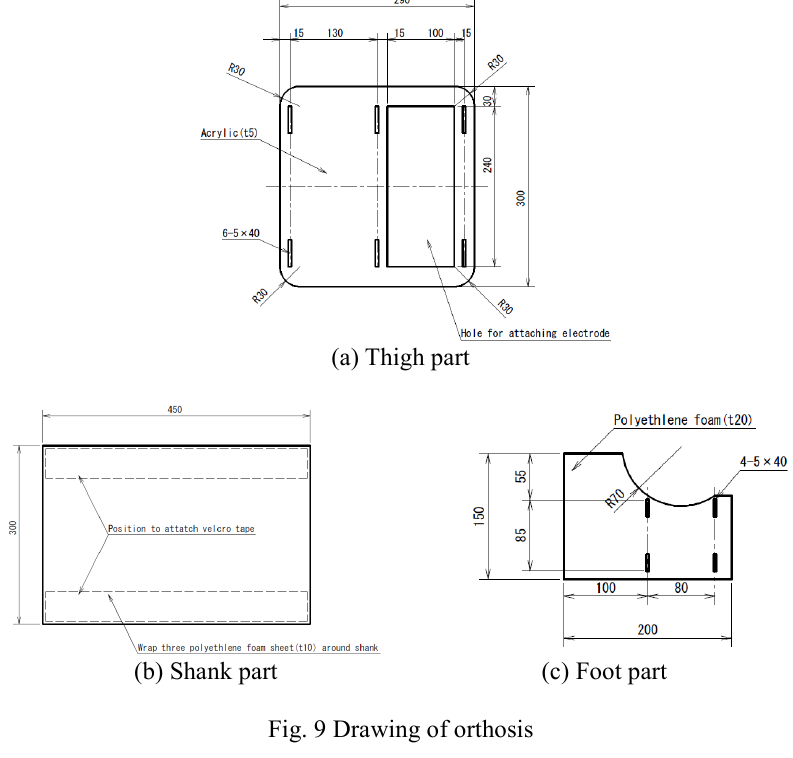
Fig. 9 Drawing of